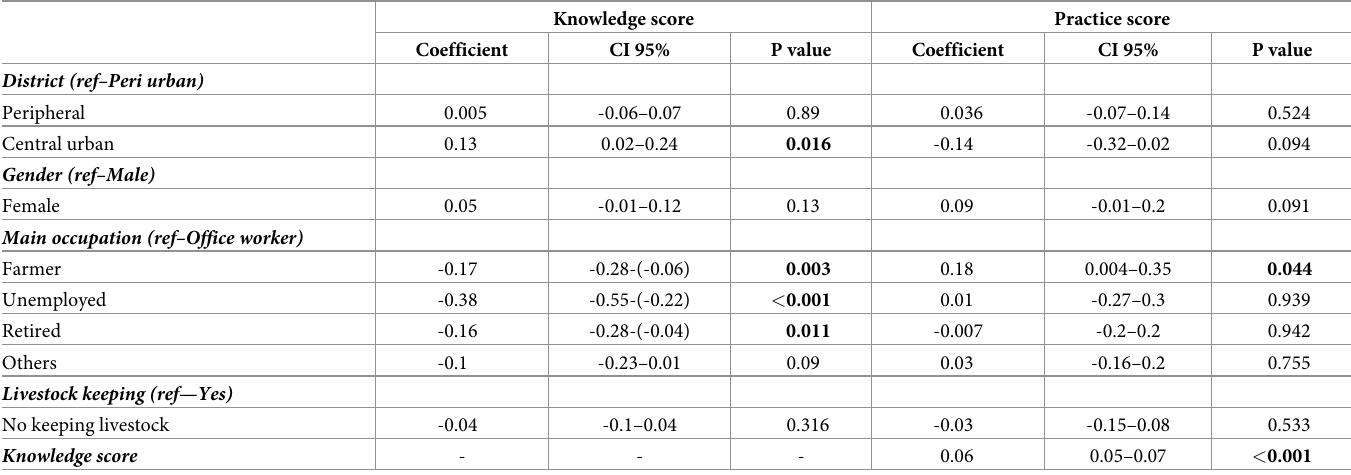
Table 4. Associated factors with knowledge and practice about MBDs.